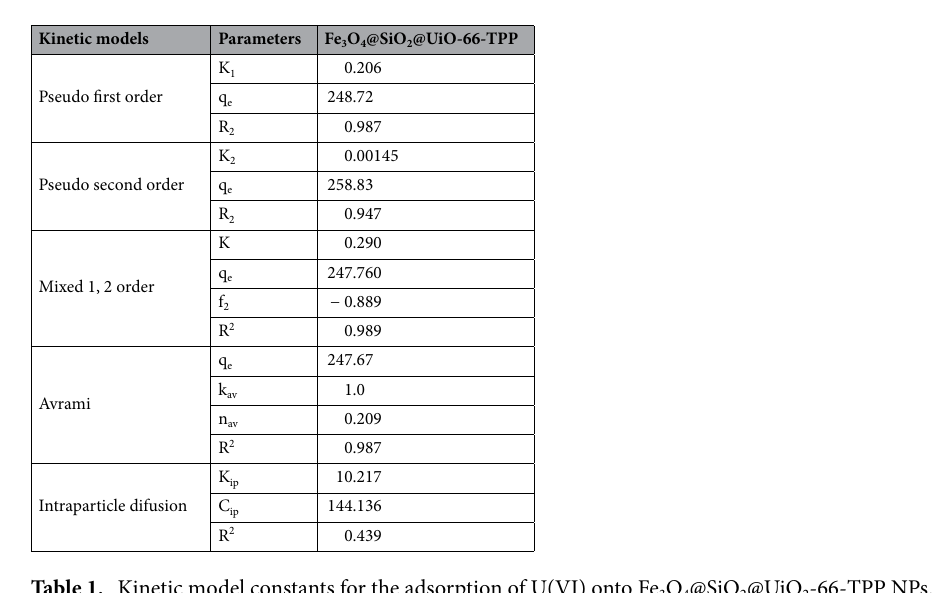
Table 1. Kinetic model constants for the adsorption of U(VI) onto Fe 3 O 4 @SiO 2 @UiO 2 -66-TPP NPs.